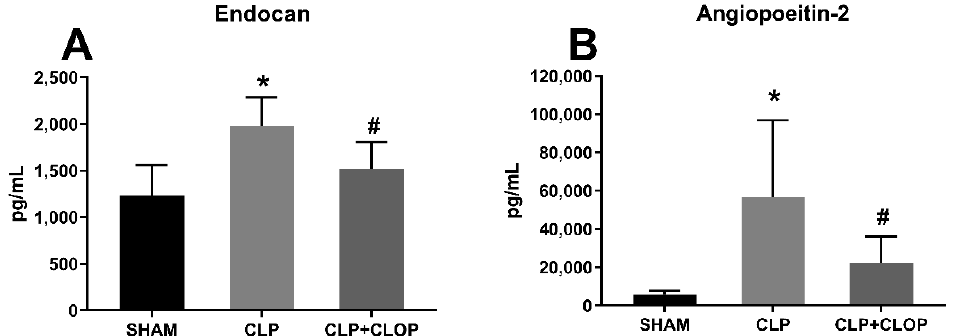
Figure 4. Endothelial activation. Plasma levels of endocan ( n = 10/group) ( A ) and angiopoietin-2 ( n = 7–8/group) ( B ), soluble markers of endothelial activation were measured in Sham, CLP and CLP + CLOP via ELISA. * p < 0.05 vs. Sham, # p < 0.05 vs. CLP.